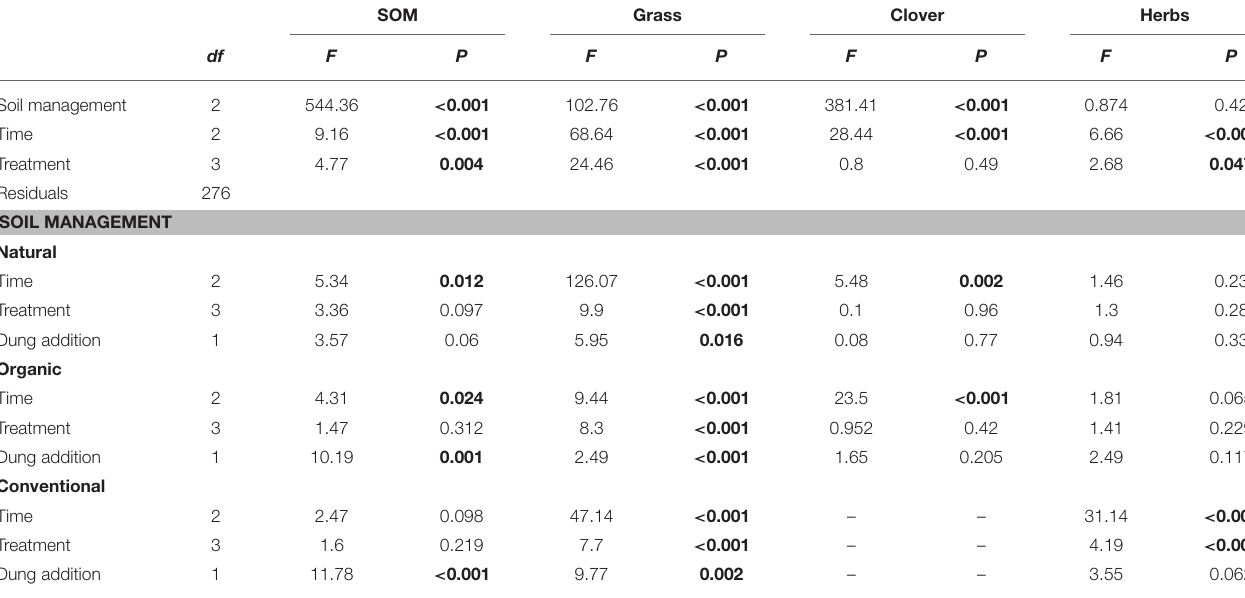
TABLE 2 | Effects of the experimental variables on SOM and plant-productivity by analysis of variance (ANOVA). SOM Grass Clover